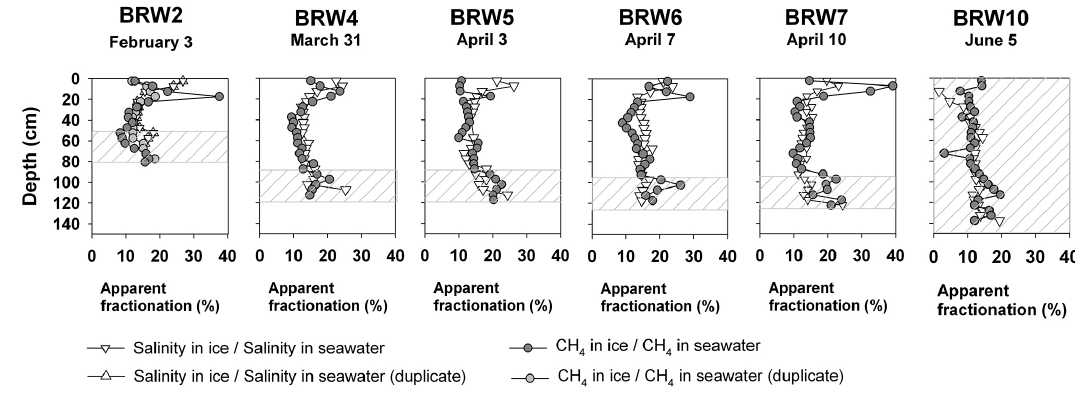
Figure 5. Comparison between the apparent fractionation of salinity in ice (the ratio between ice salinity and seawater salinity (32)) and the apparent fractionation of CH 4 (the ratio between CH 4 in ice and CH 4 in seawater (44nmolL − 1 sw )) . The seawater salinity and CH 4 in seawater that are chosen as references were the values obtained from BRW2. Dashed areas are permeable layers (i.e. layers with a brine volume fraction above